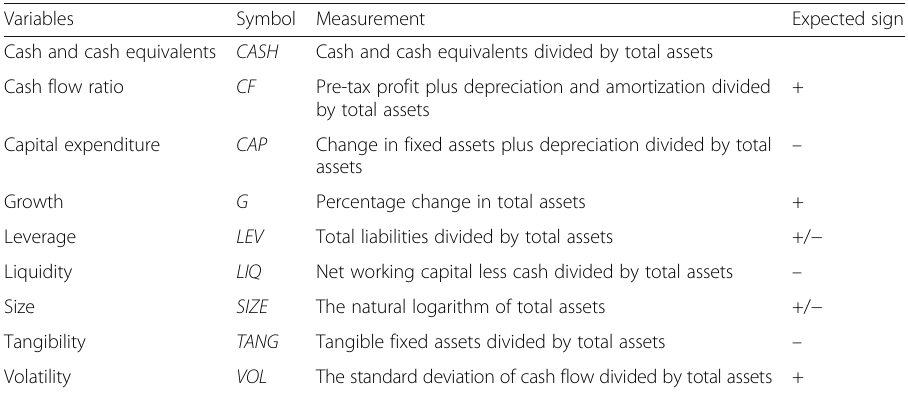
Variables Symbol